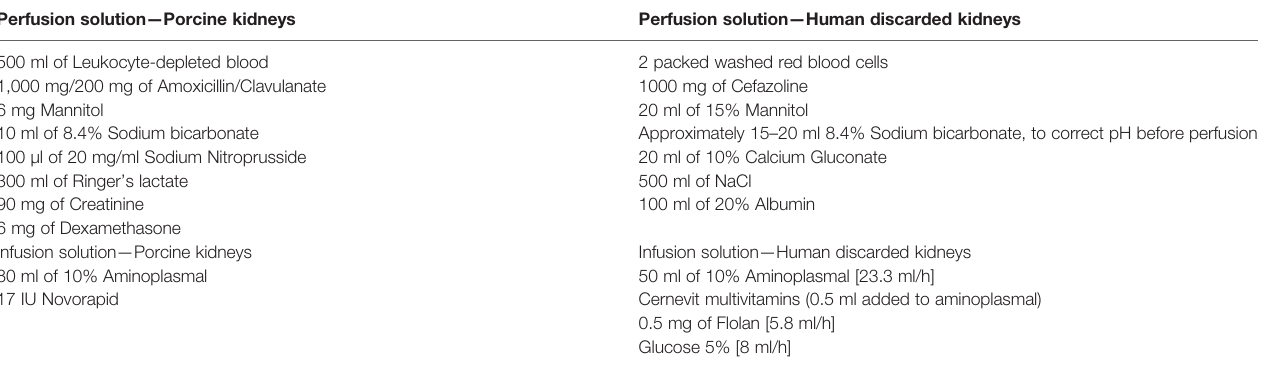
TABLE 1 | Composition of the perfusion solution used for normothermic machine perfusion. Perfusion solution — Porcine kidneys Perfusion solution — Human discarded kidneys